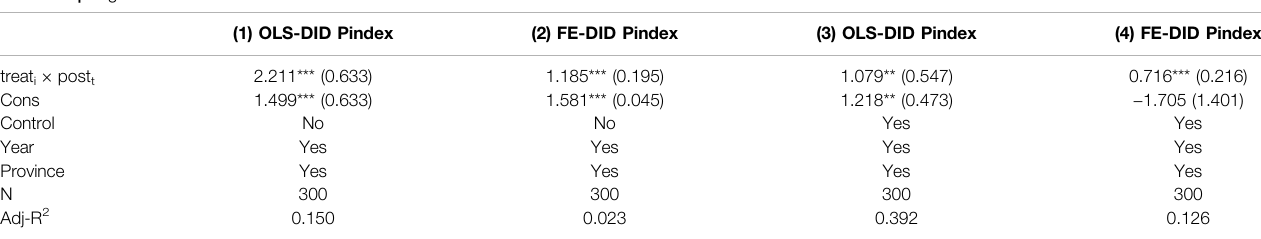
TABLE 3 | Regression